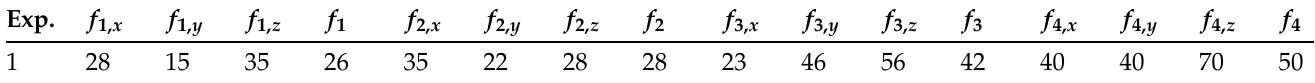
Table 8. ET frequency reduction rates during the Prototype (B) Open-Loop evaluation.